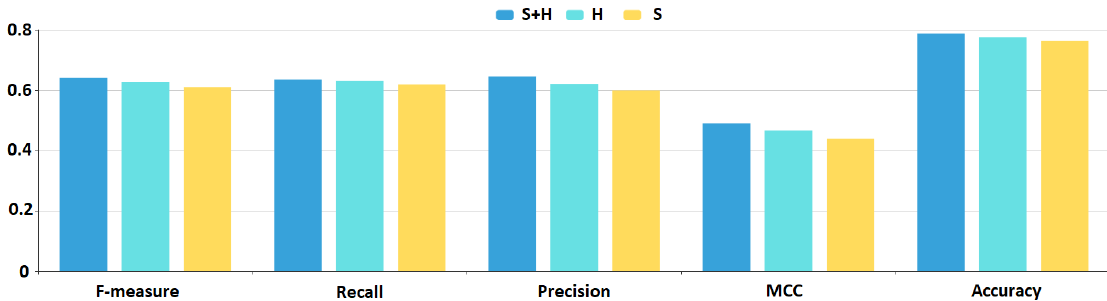
Figure 13. K-nearest